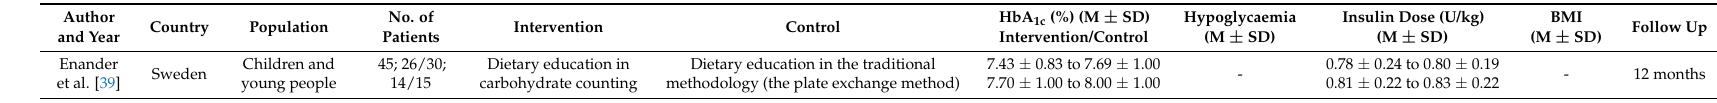
Table 2. Characteristics of controlled, randomised study with carbohydrate counting (CC) used in children and adolescents with type 1 diabetes (T1D). Author and Year Country Follow Up Enander Children and 45; 26/30; Dietary education in Dietary education in the traditional et al. [39] Sweden young people 14/15 carbohydrate counting methodology (the plate exchange